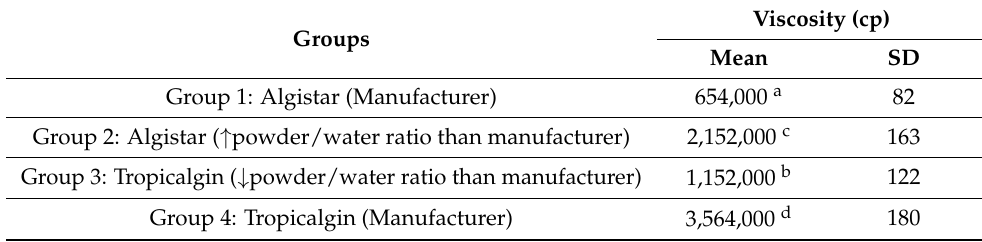
Table 3. Viscosity of the different groups (cp).